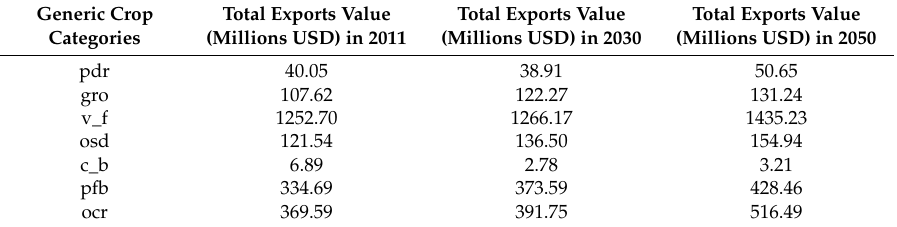
Table 3. Total exports value of the crops in 2011, 2030, and 2050 in constant 2011